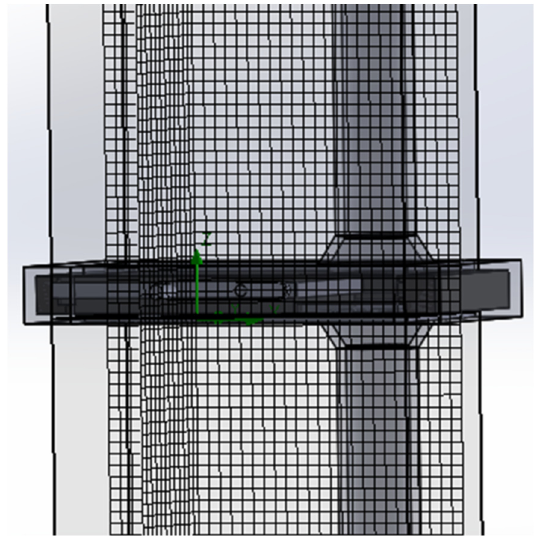
Figure 5. Cell shape in valve geometry.